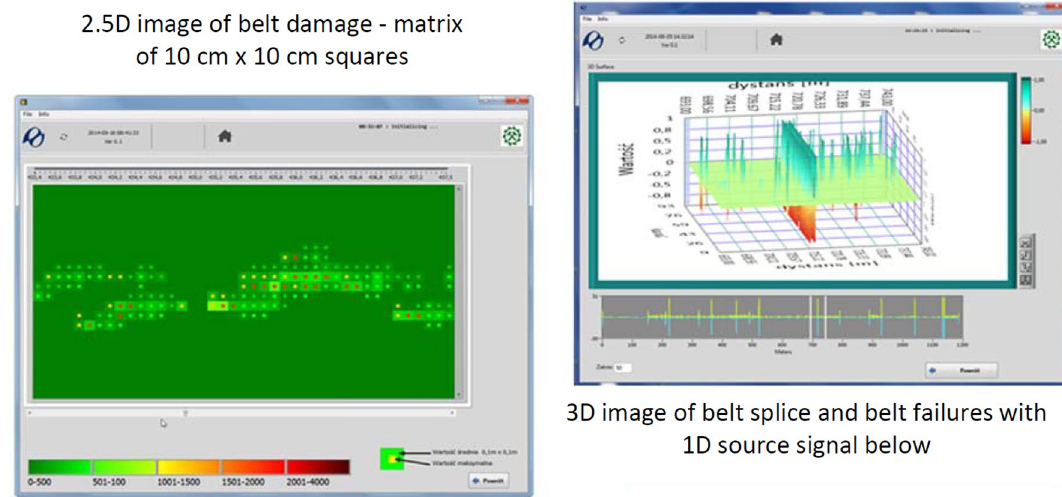
Figure 2. Various methods for imaging defects in the core and in the splice: 2.5 D matrix 10 × 10 cm (left) and 3D and 1 D signal (top right and bottom right) 12 (screenshot of DiagBelt proprietary software, version 1.0, http:// diagb elt. pwr. edu. pl/).